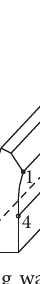
Figure 8: Displacement of the platform under different excavation distances: (a) horizontal displacement; (b) vertical displacement.